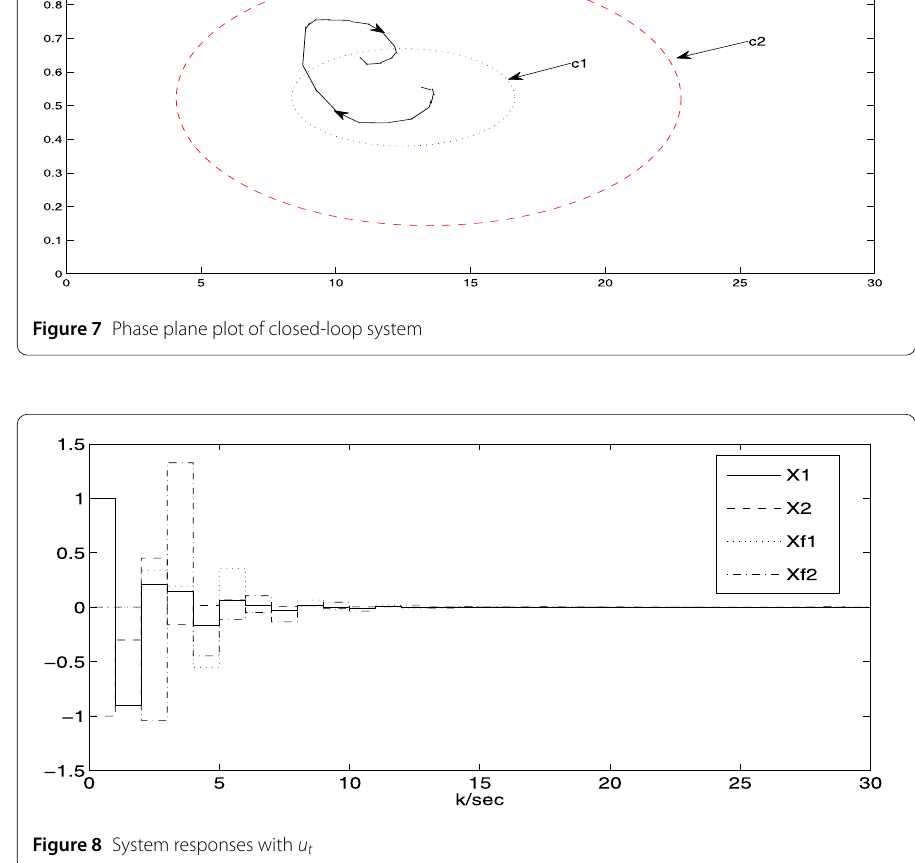
Figure 8 System responses with u